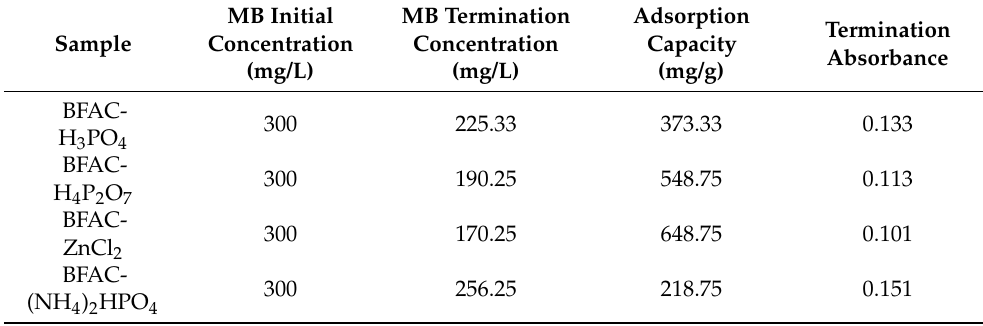
Table 4. Methylene blue adsorption of BFACs.